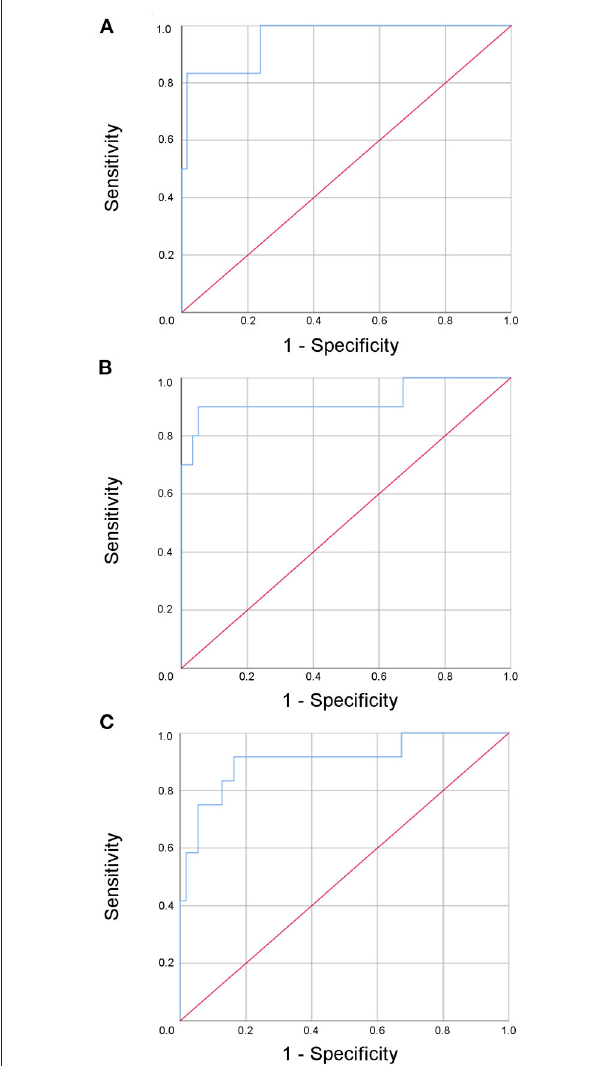
FIGURE 4 | Receiver operated curve (ROC) analysis of the multi-modal biomarker panel for the prediction of an excellent outcome after three (A) , six (B) , and twelve (C) months for patients with minor ischemic